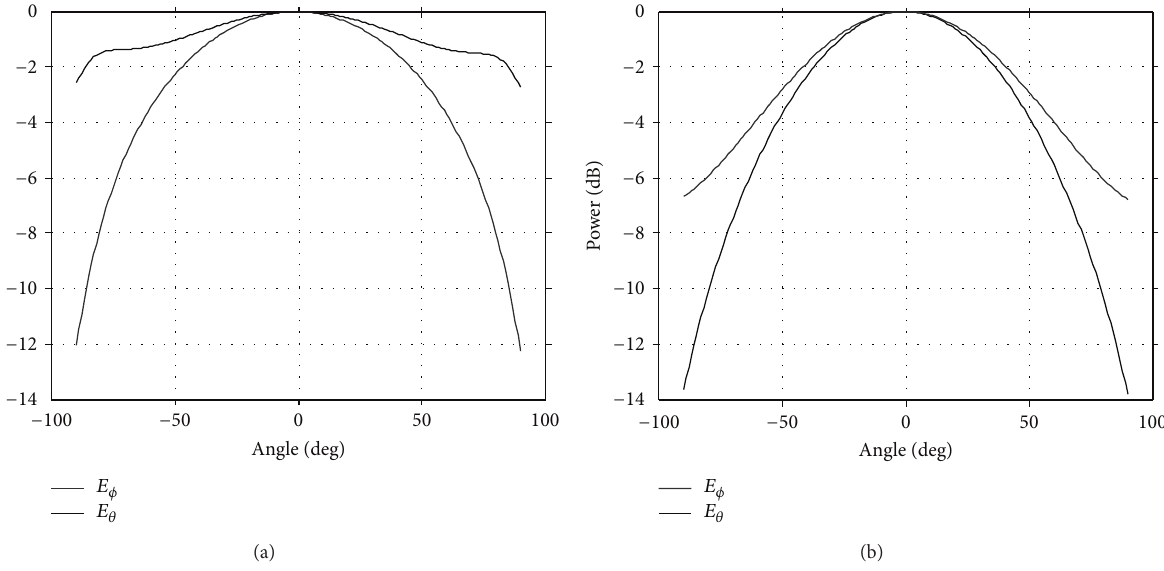
Figure 9: Amplitude radiation patterns of circular waveguide. (a) 𝑟 = 𝐷 2 /𝜆 ; (b) 𝑟 = 2𝐷 2 /𝜆 .